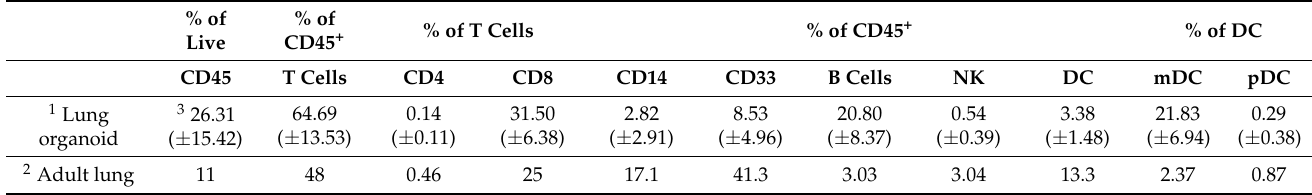
Table 2. Human immune cell reconstitution in the lung organoids of TKO-BLT-L mice and an adult human